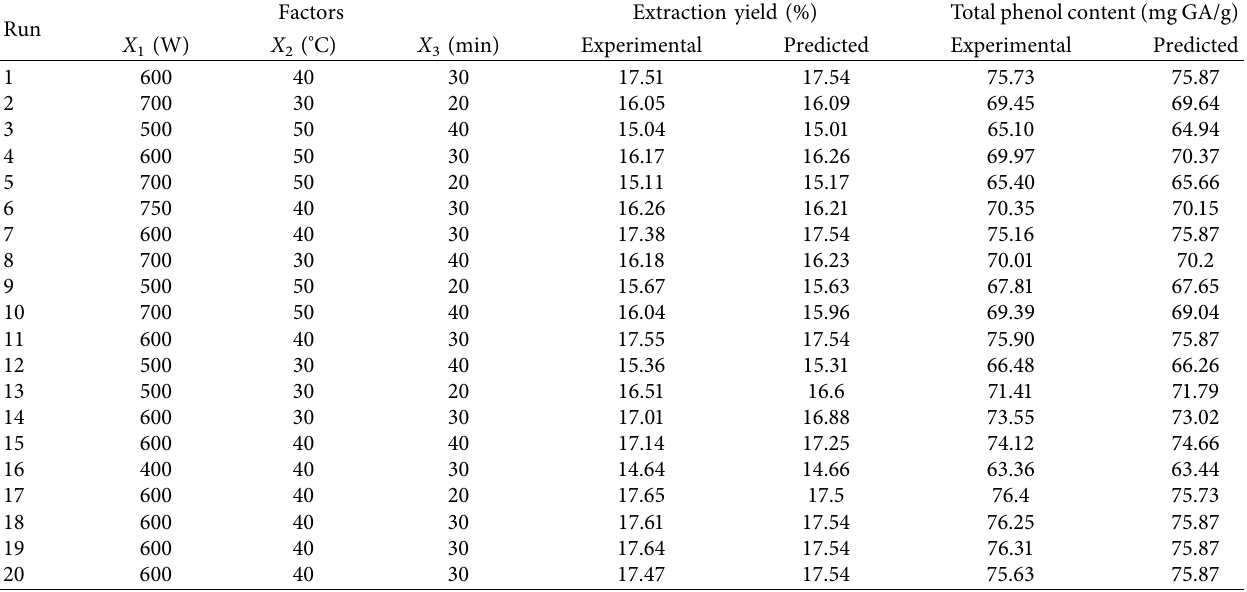
Table 2: Optimization of extraction parameters for moringa leaf powder using MAE by RSM.